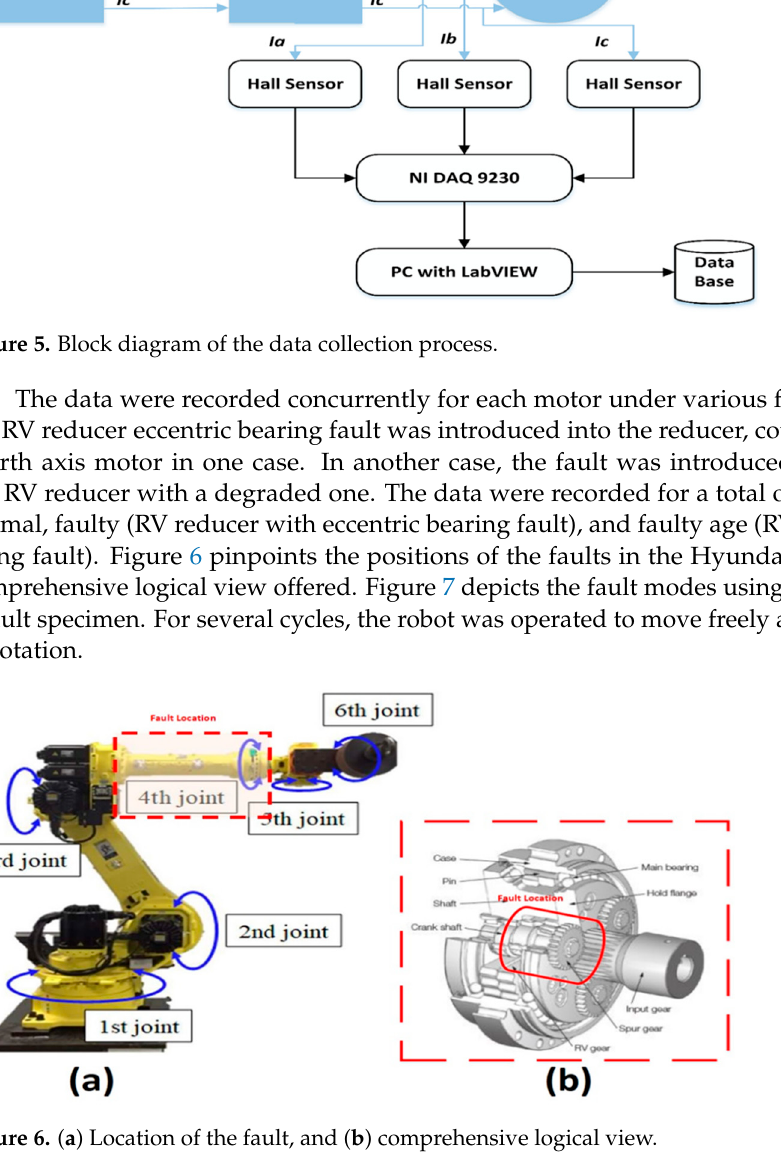
Figure 7. Example of a faulty specimen and fault types.